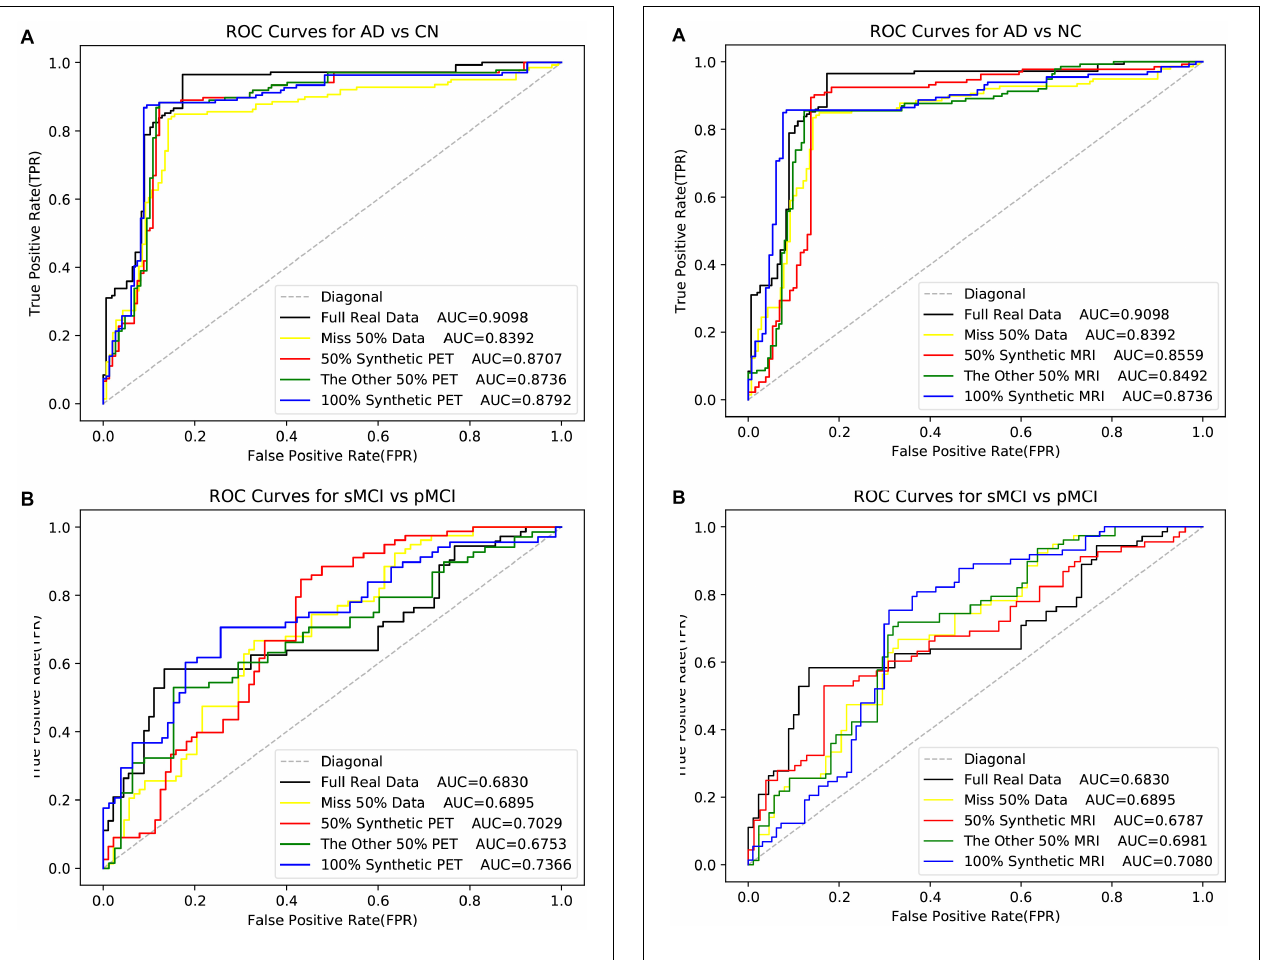
FIGURE 8 | The ROI data is used here. The ROC curves in the experiment of disease classification with the synthetic PET image.